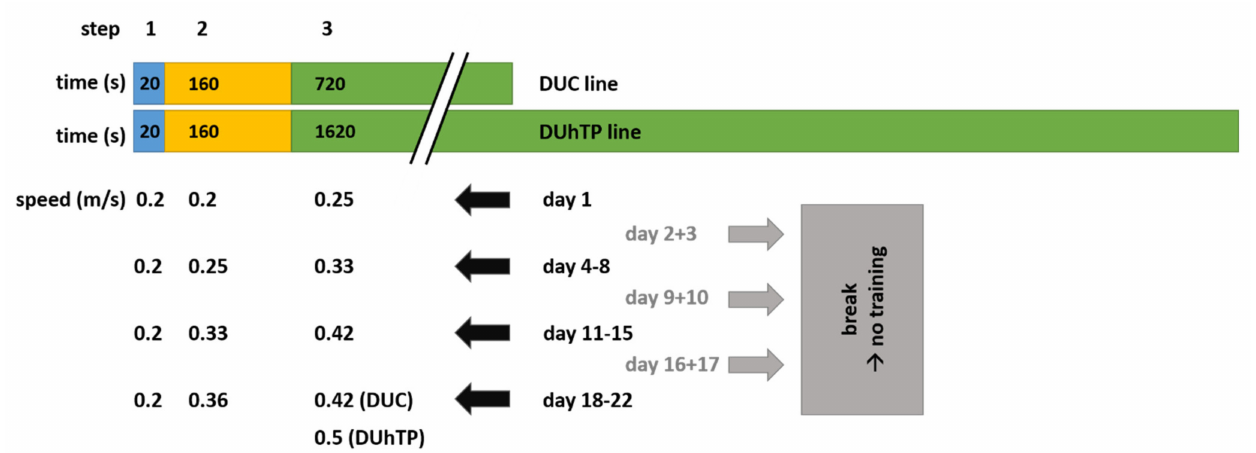
Figure 1. Three-week training program for high running performance (DUhTP) and unselected control (DUC) mice. From day 49, the animals passed a training program on a computer-controlled treadmill for 30 min (DUhTP) and 15 min (DUC) for five days per week, respectively. The duration of running corresponds to 22.56% of their last tested submaximal running performance. The final running speed of a half meter per second was stepwise